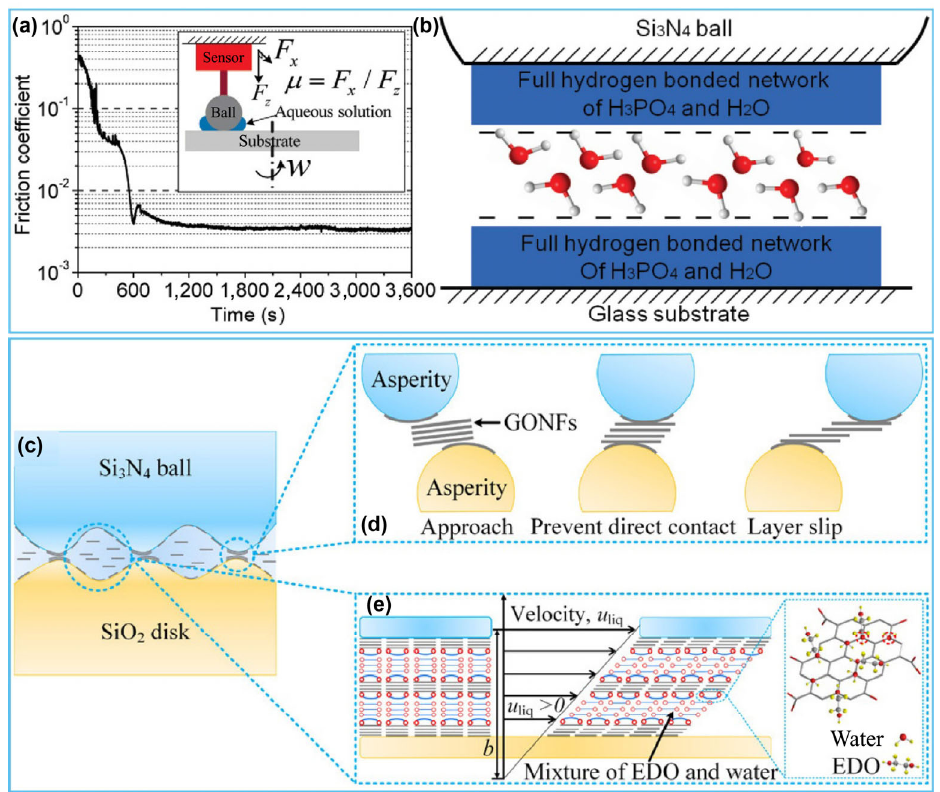
Fig. 8 (a) Friction coefficient with time between Si 3 N 4 ball and glass slide under phosphoric acid solution. (b) Sketch map of the in-situ formed structure on the two surfaces. Reproduced with permission from Ref. [86], © American Chemical Society 2011. (c) Model of the measurement system. (d) Proposed mechanism at asperity contact region during friction. (e) Proposed mechanism at liquid-contact region during friction. Reproduced with permission from Ref. [97], © American Chemical Society